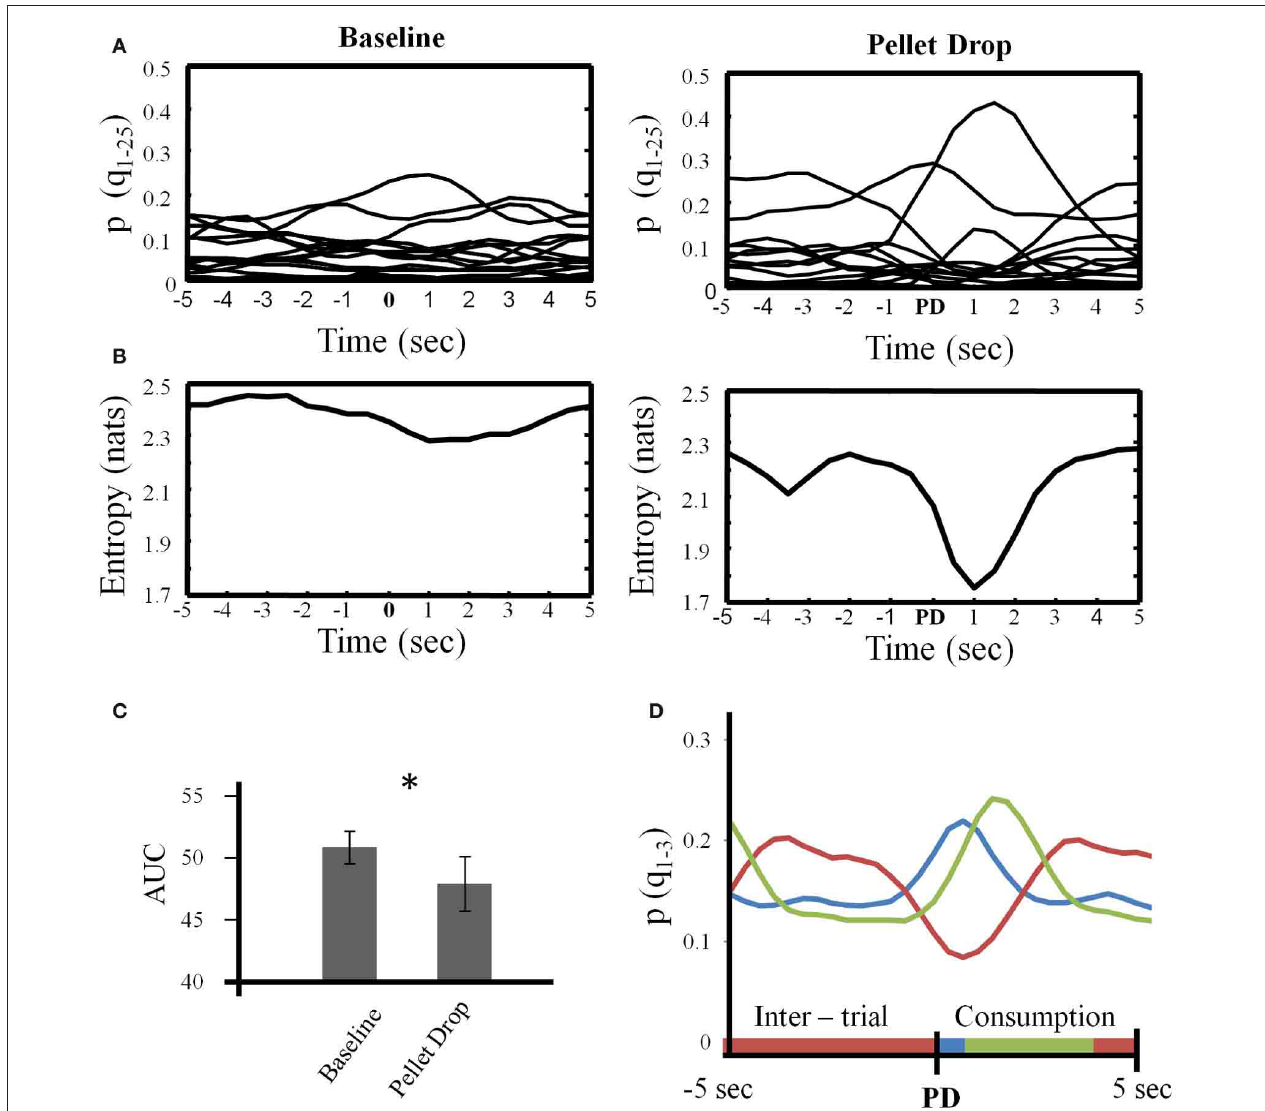
FIGURE 8 | State dynamics in the 10s period surrounding each pellet drop. (A) For a single session, the posterior probabilities of all states ( Q = 25) were individually averaged across repeated 10s intervals during the baseline period (left) and during repeated 10s intervals centered on the pellet drop during the pellet drop period (right). (B) Entropy calculated based on the average posterior probabilities shown in (A) . Note that local entropy decreased just prior to the pellet drop and reached a minimum just after it. (C) Group data from all sessions showing that the area under